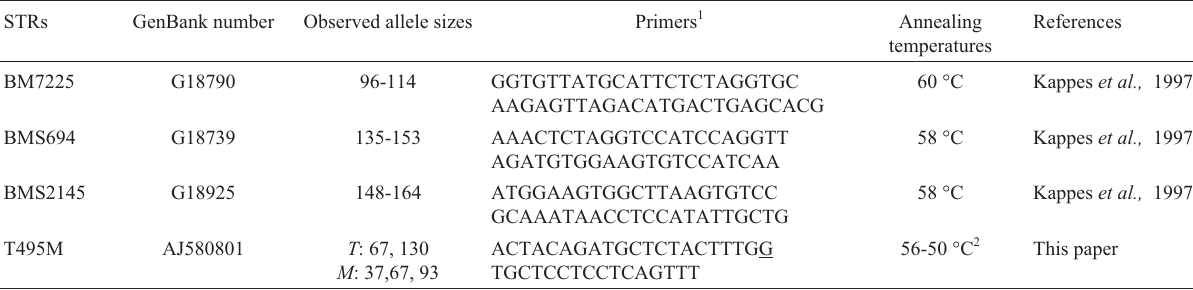
Table 1 - Molecular markers mapped at BTA3 and analyzed in the present